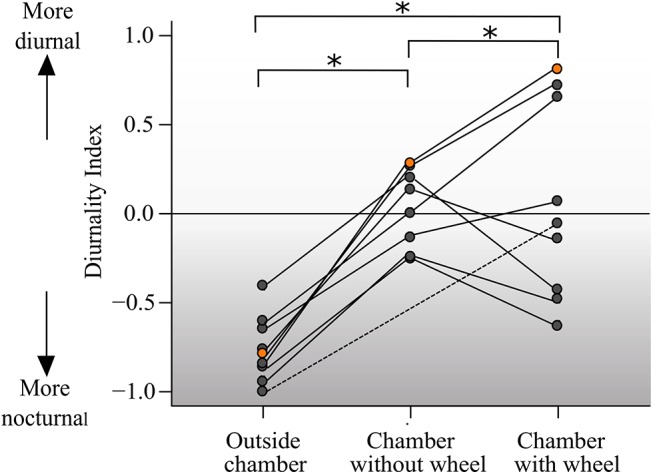
Variation of diurnality indices across the stages of the experiment.D-index for individual tuco-tucos (N = 9) along days outside and inside the respirometry chamber both with and without running-wheels. D-Index for each individual in the different conditions are connected by a line. Points in orange indicate the values for animal #143 which showed the highest discrepancy in D-Indices across conditions. Dashed line connects the values for animal #146, which was not submitted to the “chamber without wheel” condition.